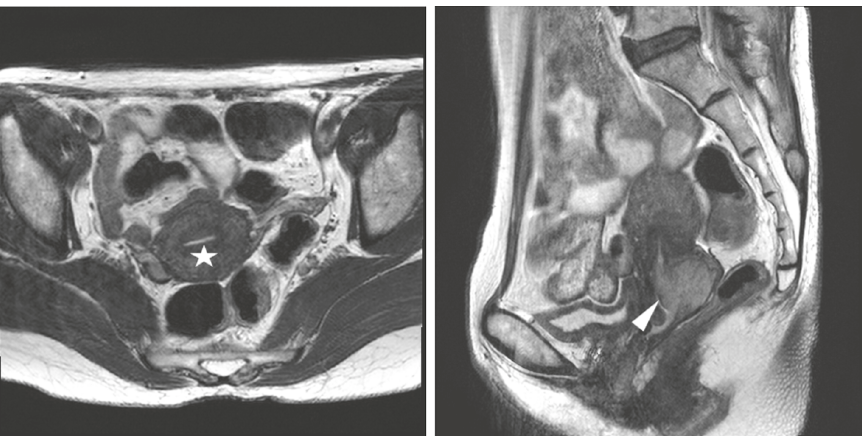
Figure 6: Stage IB1 squamous cervical carcinoma in a 51-year-old woman with radical hysterectomy (A) T2-weighted axial MR images show as 2.7 cm lobulated mass (star) on posterior lip of uterine cervix with no disruption of peripheral rim. The maximum diameter of the lesion is measured 2.7cm (arrowhead) on the T2-weighted sagittal image. At histopathological finding, bilateral parametrial lesion was found. MRI stage T1b ( ≤ 4 cm) was underdiagnosed as final pathologic stage T2b.